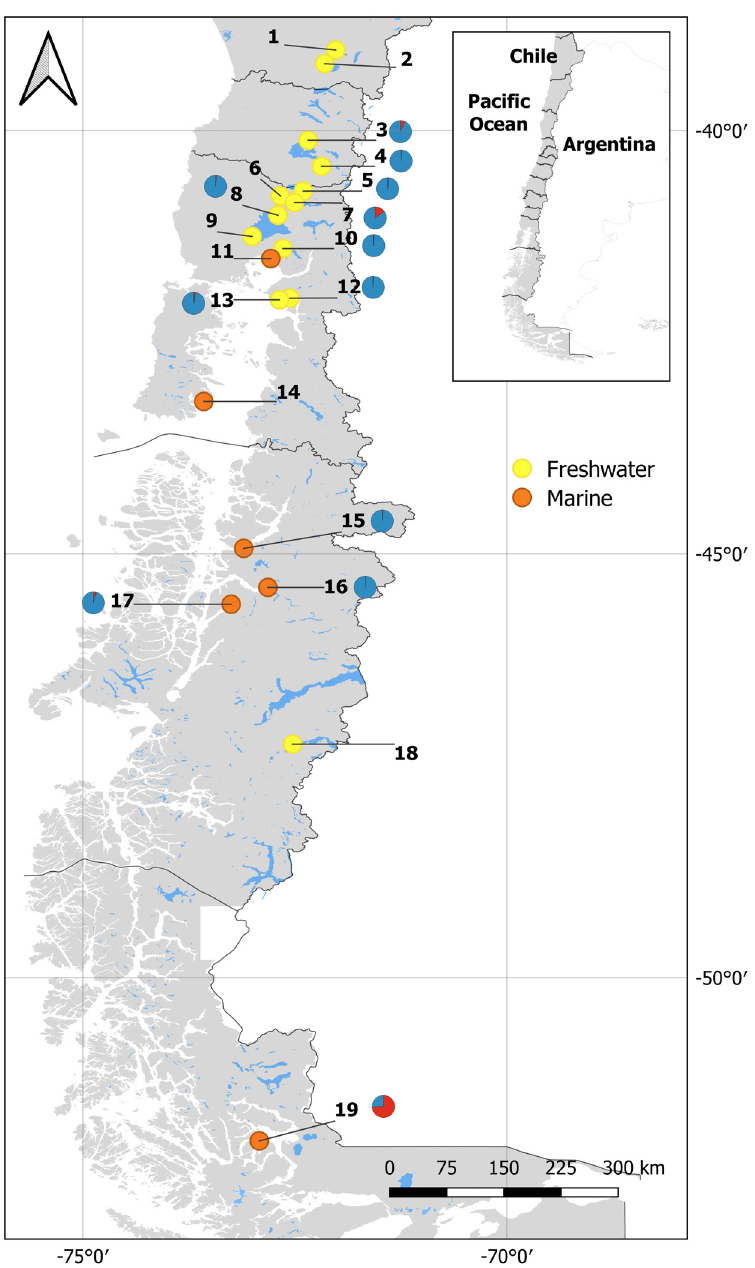
Fig. 1. Collection sites of free-living Atlantic salmon in freshwater and marine locations. Pie charts from sites that passed quality control show genetic membership to 2 clusters: European (blue) or North American (red) function, which uses a k -means clustering algorithm that maximizes genetic differences between groups and minimizes genetic differences within groups over 10 6 iterations. The optimum number of retained prin- cipal components was inferred by a cross-validation method using the ‘xvalDapc’ function. Cluster mod-